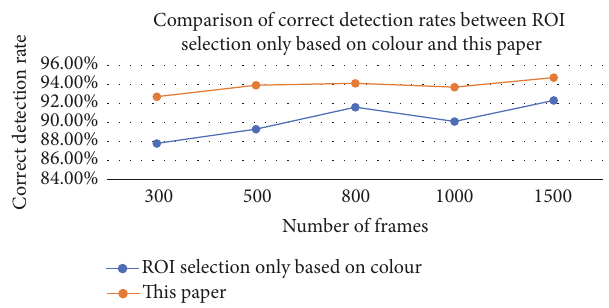
Figure 21: Comparison of correct detection rates between ROI selection only based on colour and this